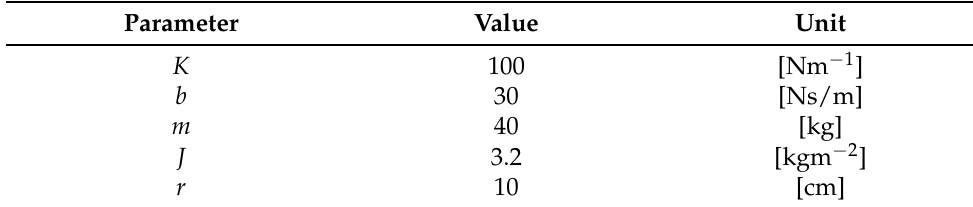
Figure 12. Rolling disc. Table 2. Parameters of the